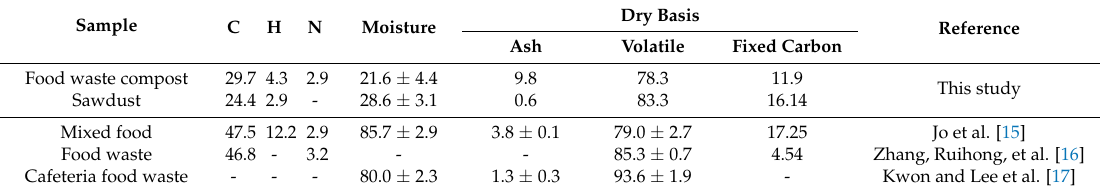
Table 1. Physical-chemical characterization of food waste compost and sawdust.